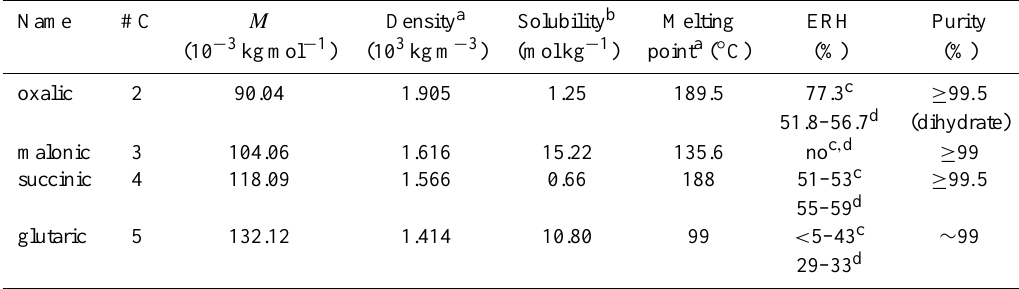
Table 1. Selected physical properties of the dicarboxylic acids used in this